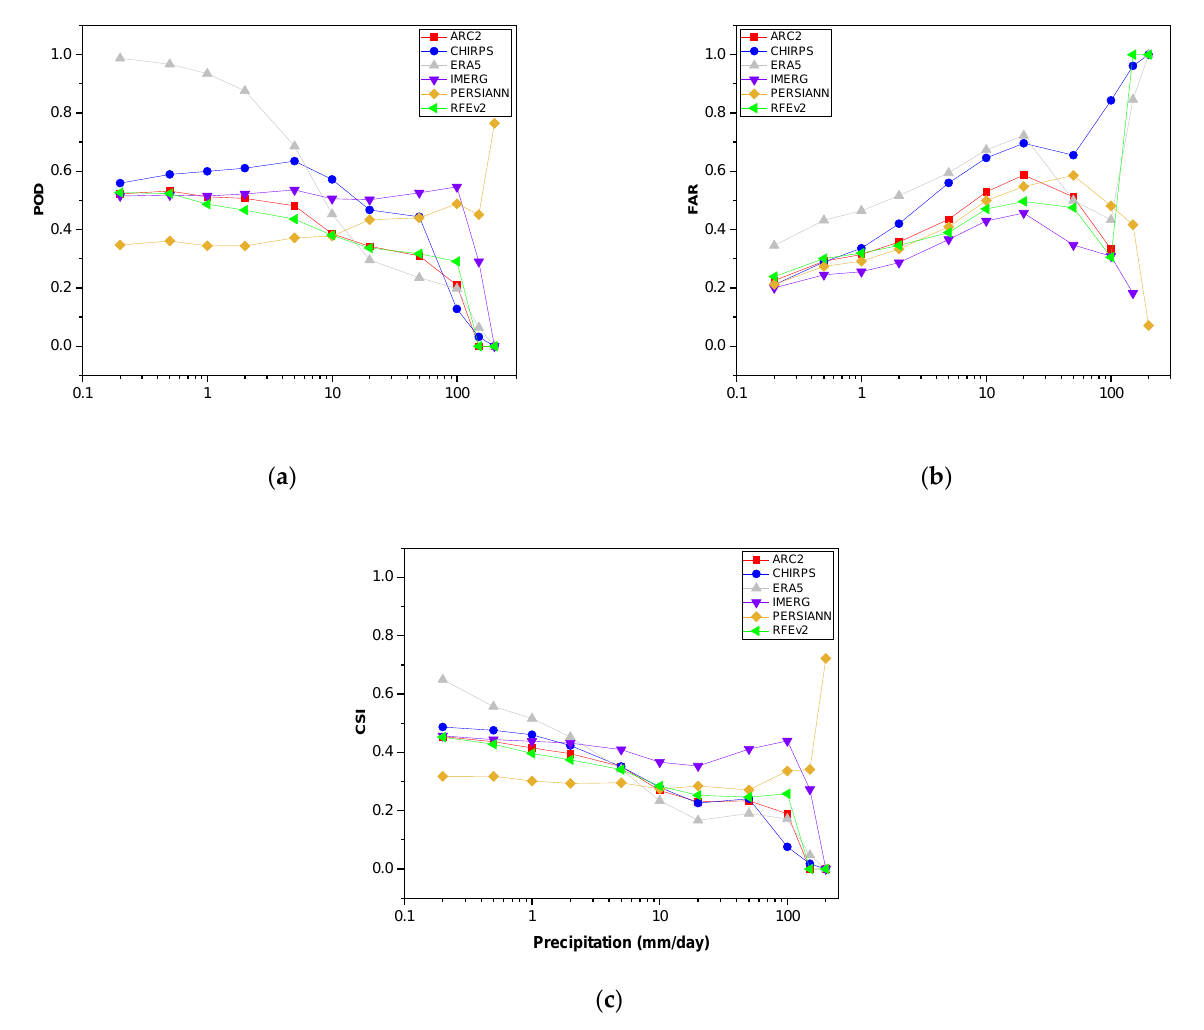
Figure 6. Precipitation detection ability of the six GPPs based on daily rainfall: ( a ) Probability of detection (POD), ( b ) False alarm ratio (FAR), ( c ) Critical success index (CSI). Ground-based rain gauge data from September 2018 to August 2020 are used as reference. Note logarithmic (Log10) scale for X axis.